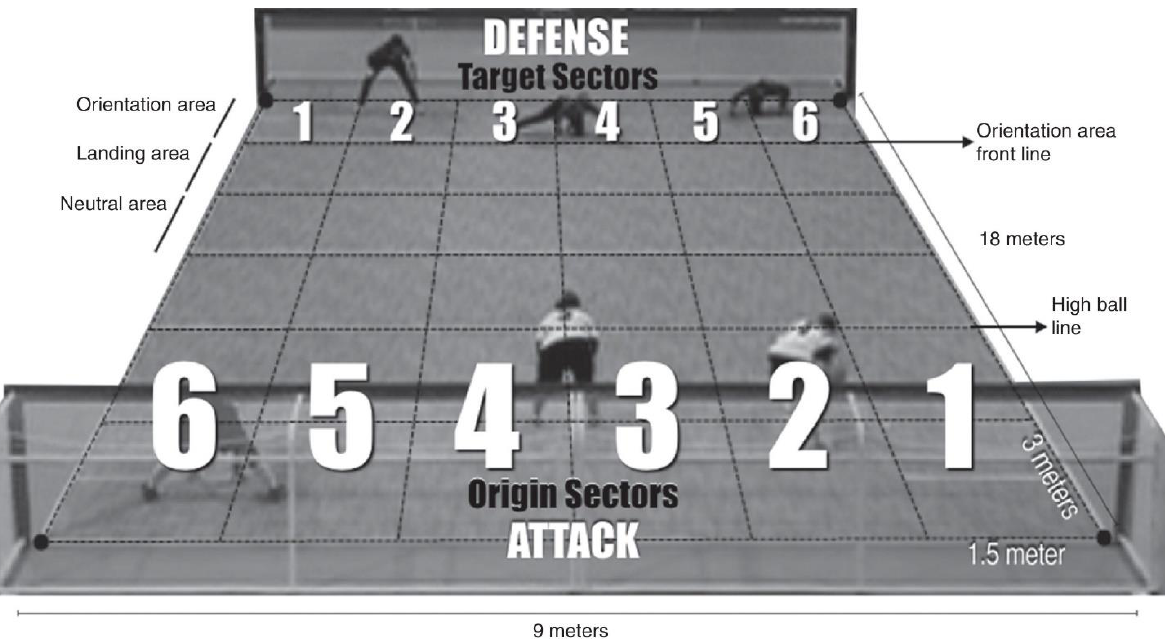
Figure 1. Illustration of the origin and target sectors in a goalball court, used with author permission from Morato, et al.,